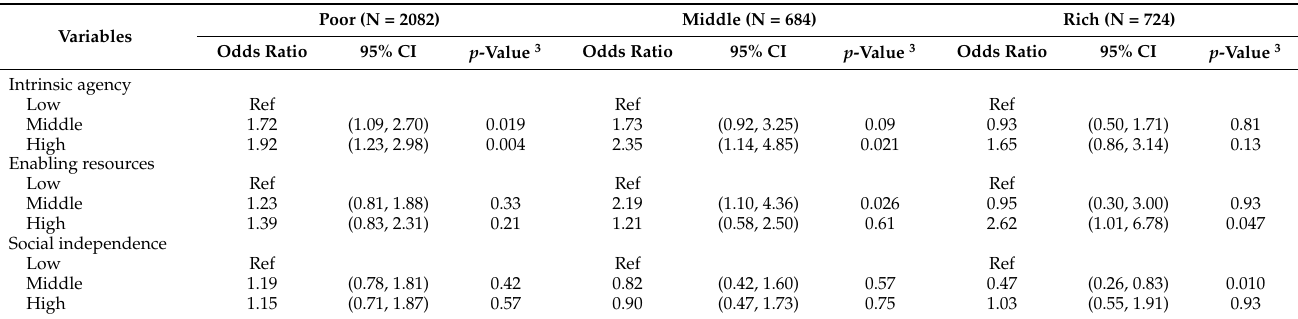
Table 4. Association between women’s empowerment and children’s complete vaccination stratified by wealth status in the DRC 1,2